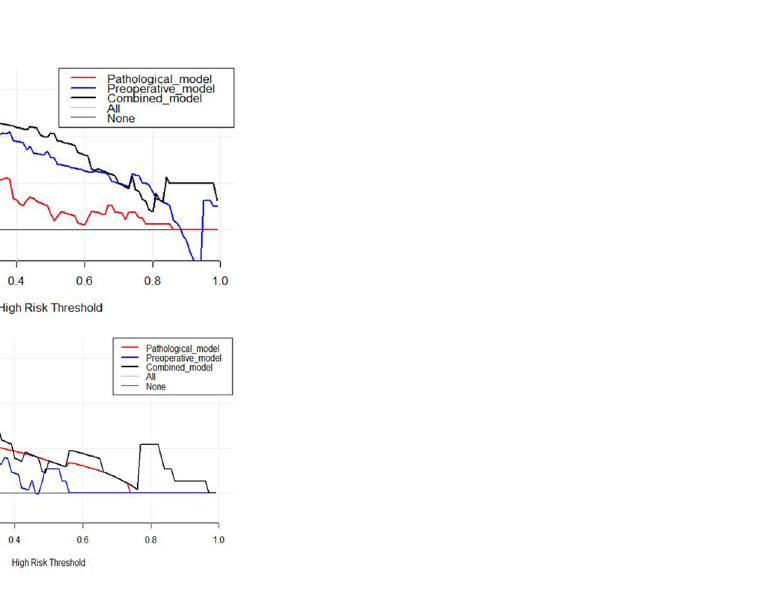
Figure 3. Delong non-parametric approach, AUC estimates for predicting early recurrence of IMCC were compared between different prediction models in the training set ( a ) and test set ( b ).